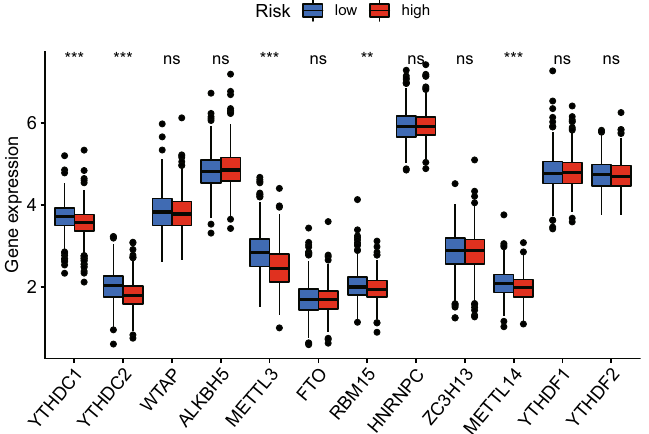
Figure 10. mRNA expression levels of 12 m6A methylation-related genes in the high- and low-risk groups.